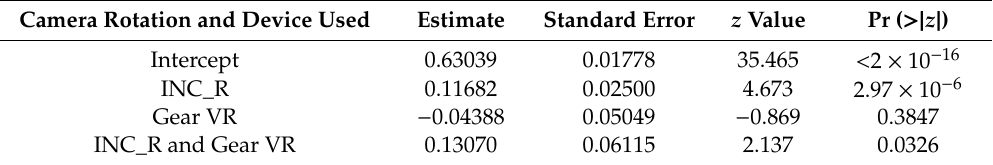
Table 23. Logistic regression analysis results of the interactions between camera rotation and the device used.